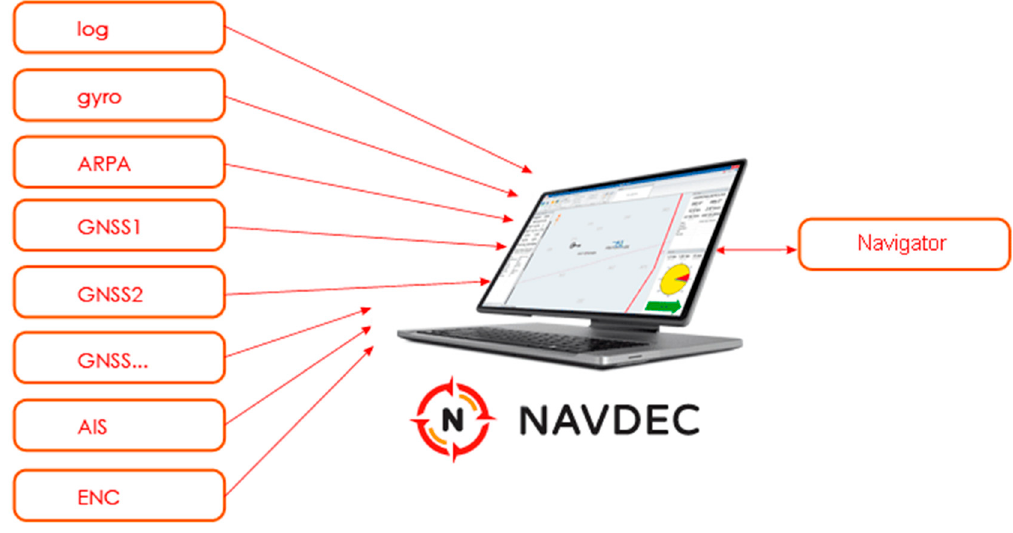
Figure 1. A diagram of the NAVDEC environment [32].